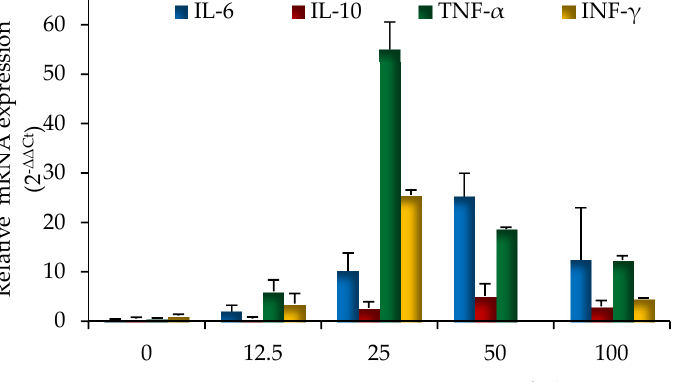
Figure 9. Relative IL-6, IL-10, TNF- α and INF- γ mRNA expression levels (2 − ∆∆ Ct ). The concentra- tion of CS-NPs is calculated considering the CS-OA content present in the colloidal system (mean values ± s.d., n =